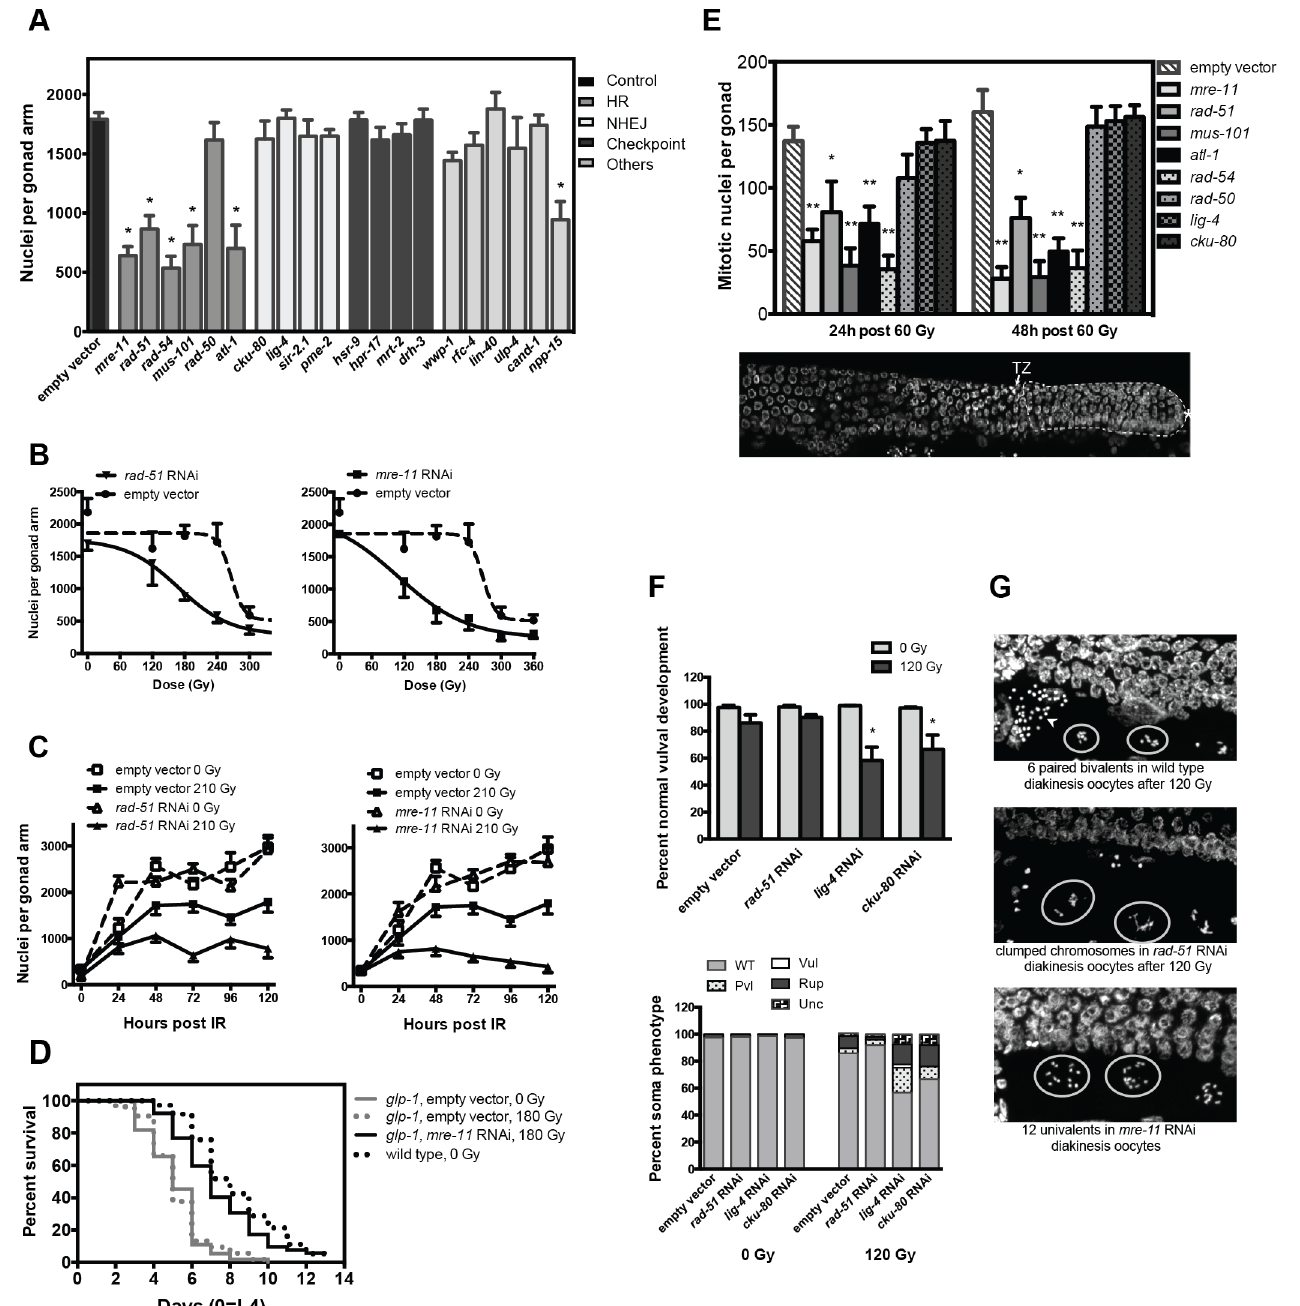
Fig 3. Radiation sensitivity of germline tumor after RNAi. (A) Knockdown of HDR ortholog genes radiosensitizes ar202 tumors. L4 ar202 worms were irradiated at 210Gy, an ineffective dose in this strain as shown in Fig 3B, and germline nuclei were quantitated at 72h post irradiation. Genes knocked down are classified according to their function in DNA damage repair pathways. Asterisks indicate significantly increased radiation sensitivity compared with empty vector control group, * p < 0.01. (B) Inactivation of rad-51 (left) or mre-11 (right) enhances radiosensitivity of germ cells. L4 ar202 worms were irradiated and germline nuclei counted 72h post radiation. Data (mean ± s.e.m) are from 5 – 8 worms ⁄ group. Note the empty vector data set is the same in left and right panel. (C) Time course of germ cell accumulation after 210Gy combined with rad-51 RNAi ( left ) or mre-11 RNAi ( right ). Data (mean ± s.e.m) are from 7 – 12 worms ⁄ group. Note the empty vector data set is the same in left and right panel. (D) mre-11 inactivation extends survival of glp-1(ar202) after 180Gy treatment of L4 larvae. Survival assays were performed at 25°C. Data are from one representative of 3 experiments scoring (cid:3) 50 animals per group. (E) Knockdown of HDR genes radiosensitizes mitotic germ cells in distal gonad of wild-type worms. L4 stage-worms were irradiated with 60Gy and mitotic germ cells were quantified as in Fig 1A. Mitotic germ cells reside between the distal end of the gonad (indicated by bold asterisk in bottom panel) and the transition zone [10], which characteristically contains crescent-shaped nuclei (arrow). * p < 0.05 and ** p < 0.01 vs. empty vector control. (F) Knockdown of NHEJ genes results in vulval